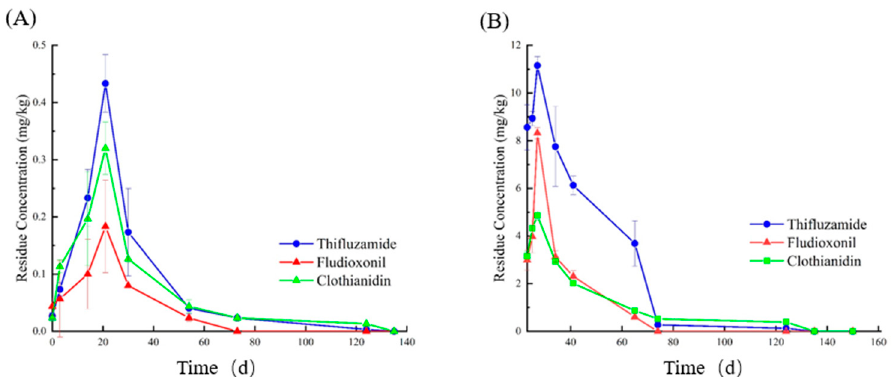
Figure 2. Dynamic changes in thifluzamide, fludioxonil, and clothianidin residues (mg kg − 1 ) in the ( A ) soil and ( B ) plant samples (the recommended dosage).